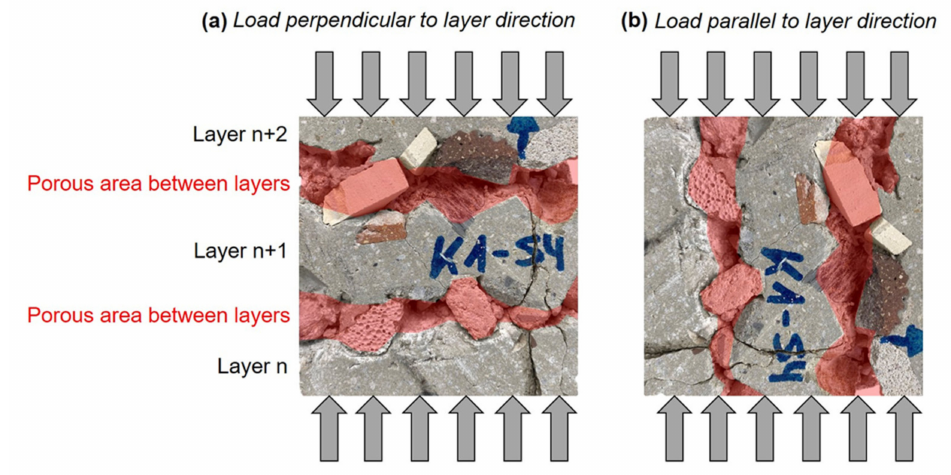
Figure 11. Layer orientation in compressive strength test specimens (particle bed A, ST0.1_SP0.5) for ( a ) load perpendicular to layer orientation and ( b ) load parallel to layer orientation—porous areas between layers are marked in